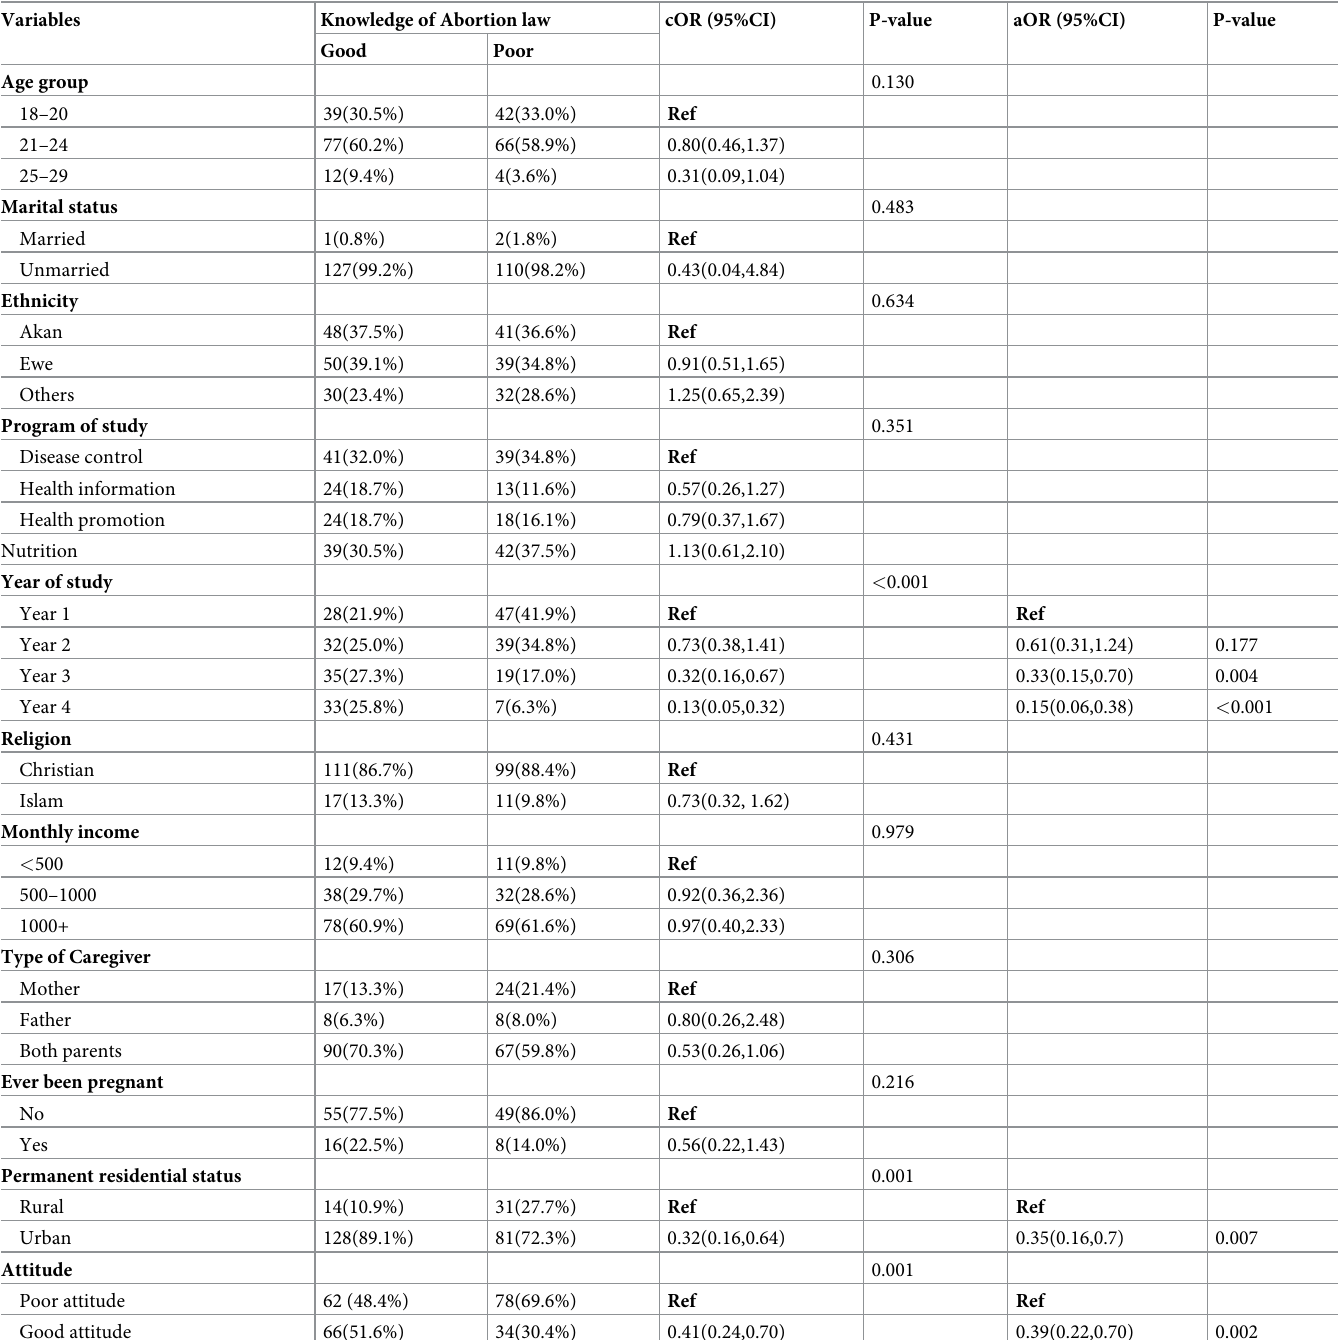
Table 5. Bivariate and multivariate analysis of factors associated with poor knowledge of Ghana’s abortion law.